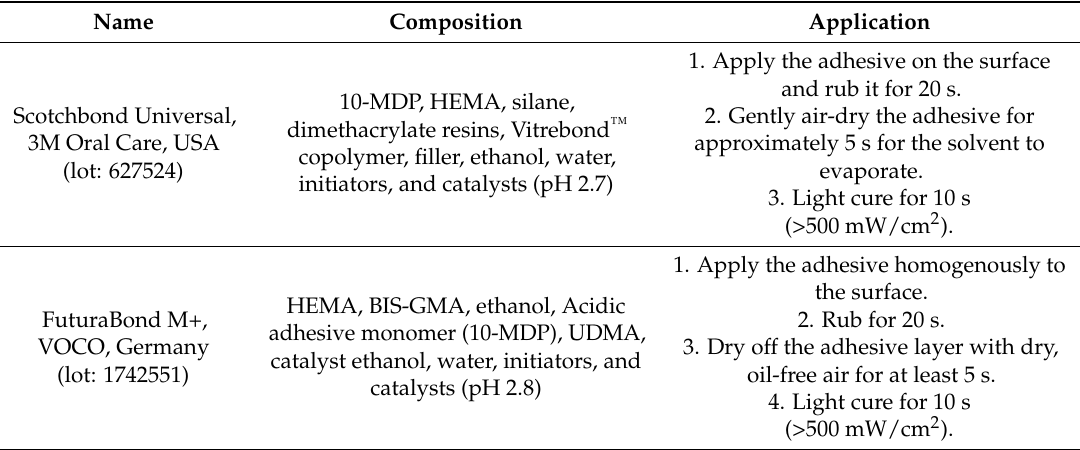
Table 1. Adhesive system, composition, and application